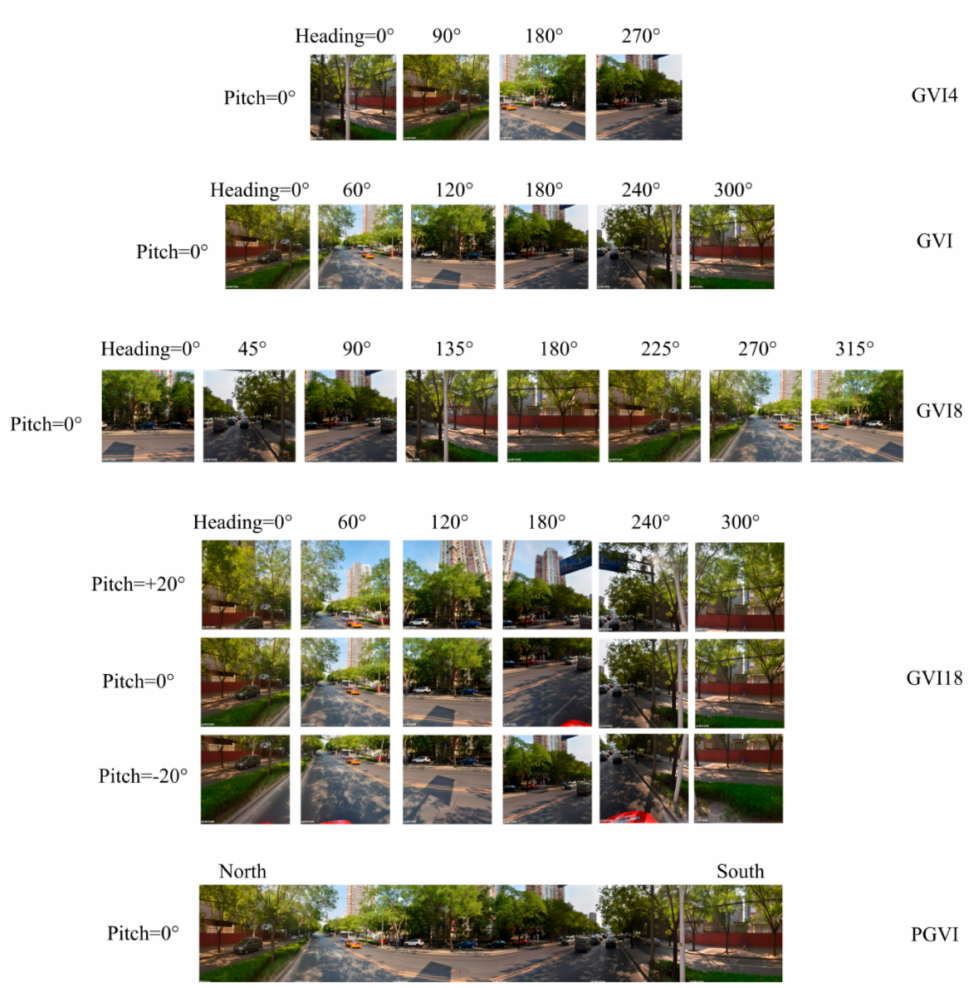
Figure 11. Five green view index (GVI) calculation methods and street view picture (SVP)